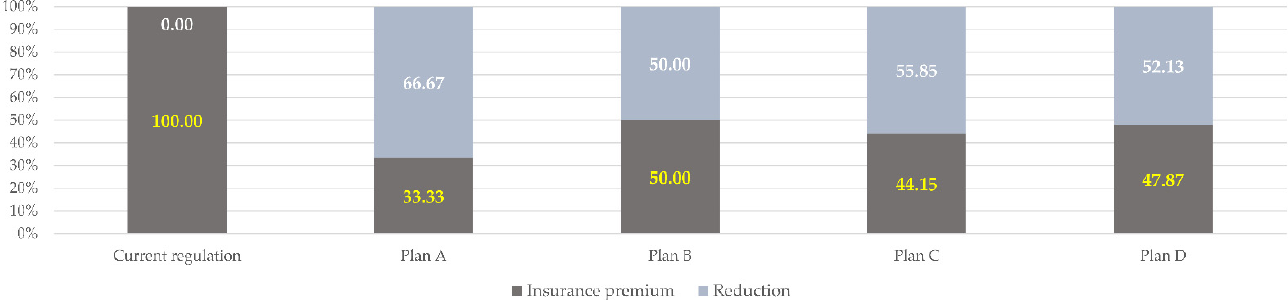
Figure 6. Comparison of reduction e ff ect for insurance premium.